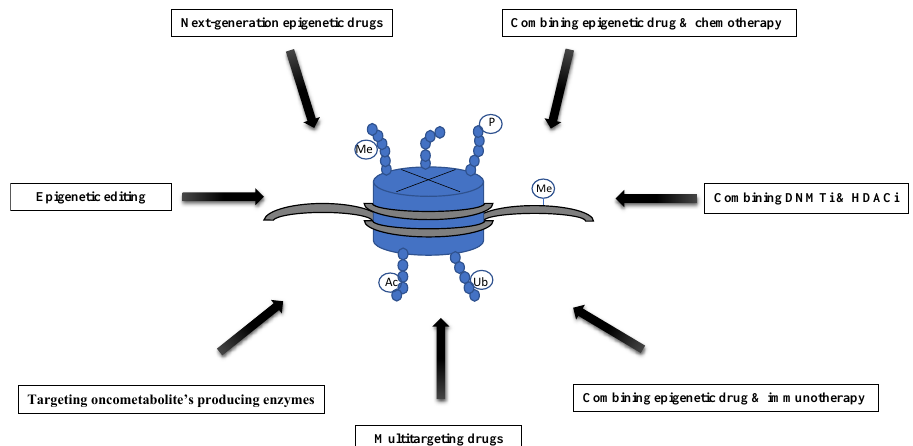
Figure 1. Overview of the new approaches to epigenetic therapies. Me — methylation, P — phosphorylation, Ac — acetylation, Ub — ubiquitination.